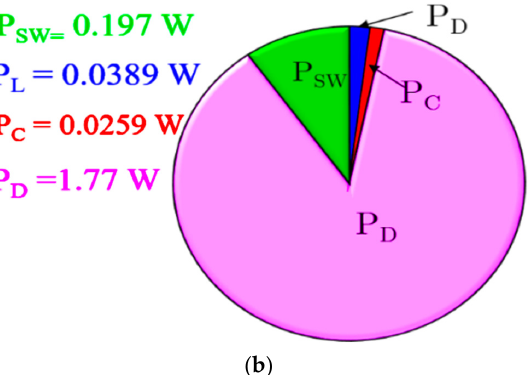
Figure 8. ( a ) Equivalent circuit for efficiency analysis. ( b ) Loss distribution of HSIVL converter at 50 W.